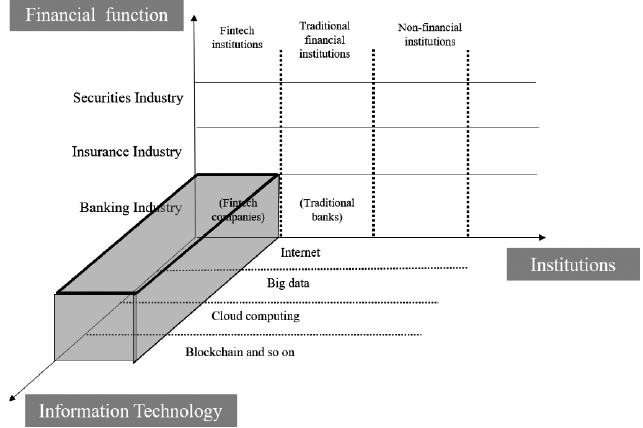
Figure 1. The three-dimensional conceptual framework for defining